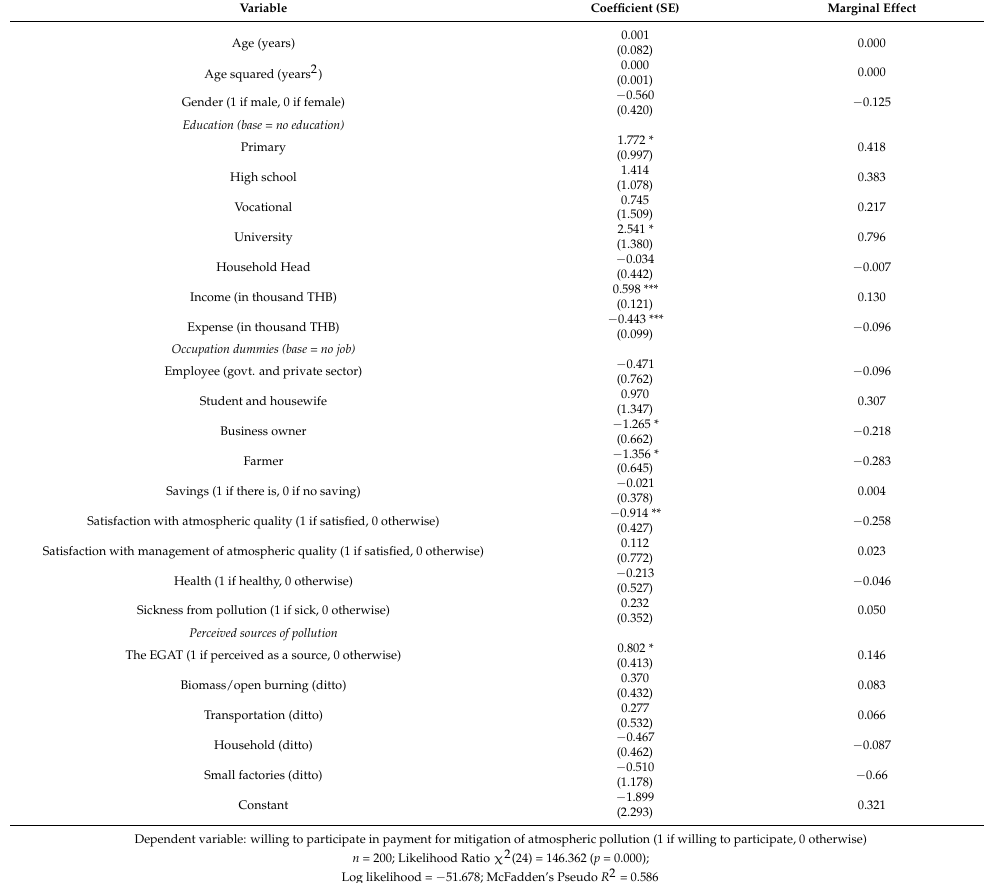
Table 10. Factors associated with the probability of willing to participate in payment for mitigation of atmospheric pollution: the probit